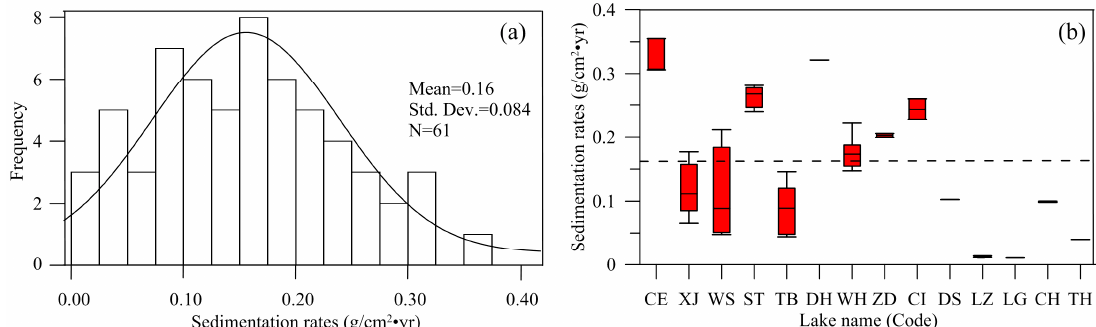
Figure 5. ( a ) Frequency distribution curve based on all data on SRs before 1900 in the 14 study lakes; and ( b ) median sedimentation rates (SRs-Median) of the 14 study lakes for the period 1850–1900. Lake code refers to Table 1. The black dashed line represents the SR reference condition.